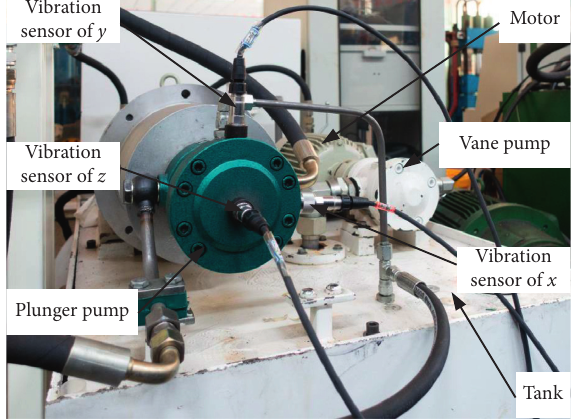
Figure 11: Physical test bench